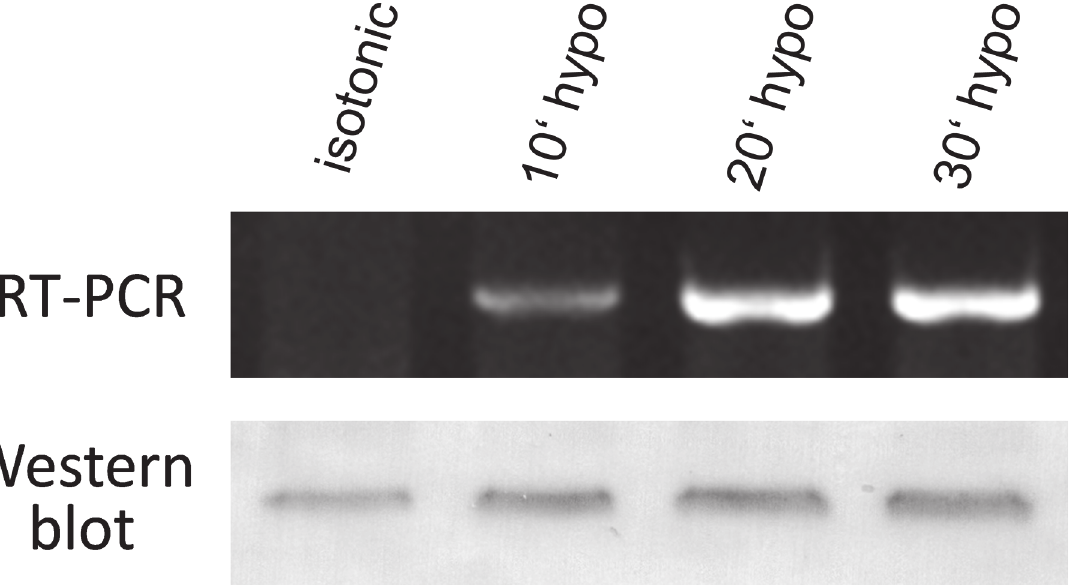
Fig 6. Hypotonic stress-induced upregulation of SLC5A3 at the mRNA and protein level in HEK293 cells revealed by semiquantitative RT-PCR and Western blot, respectively. Prior to RNA and protein extractions, the cells were incubated in 100-mOsm CGM for 10 – 30 min. Control cells were kept in isotonic CGM. The SLC5A3 mRNA level in isotonic sample was negligible, whereas hypotonicity induced substantial amounts of SLC5A3 mRNA. As with RT-PCR, Western blot analysis shows increased amounts of SLC5A3 protein (by up to * 40%, see text) in hypotonic samples. For RT-PCR, β -actin was used as a template loading control ( see Supporting information, S2 Fig., upper image). Prior to immunoblotting, reversible Ponceau-S protein staining has been used as a loading control (S2 Fig., lower